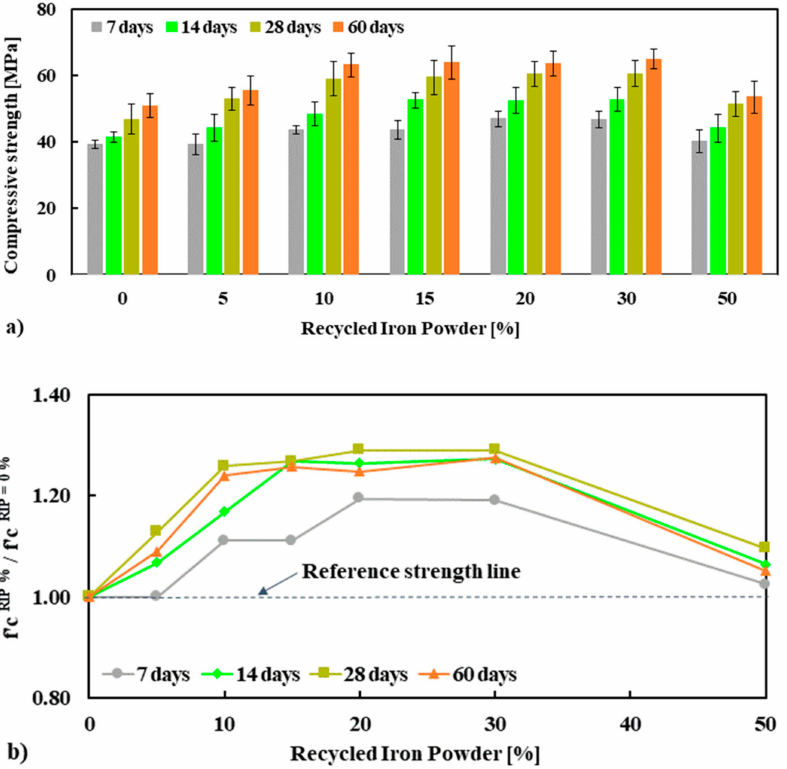
Figure 4. Compressive strength (f (cid:48) c) ( a ) and normalized f (cid:48) c ( b ) of mortar specimens tested at 7, 14, 28 and 60